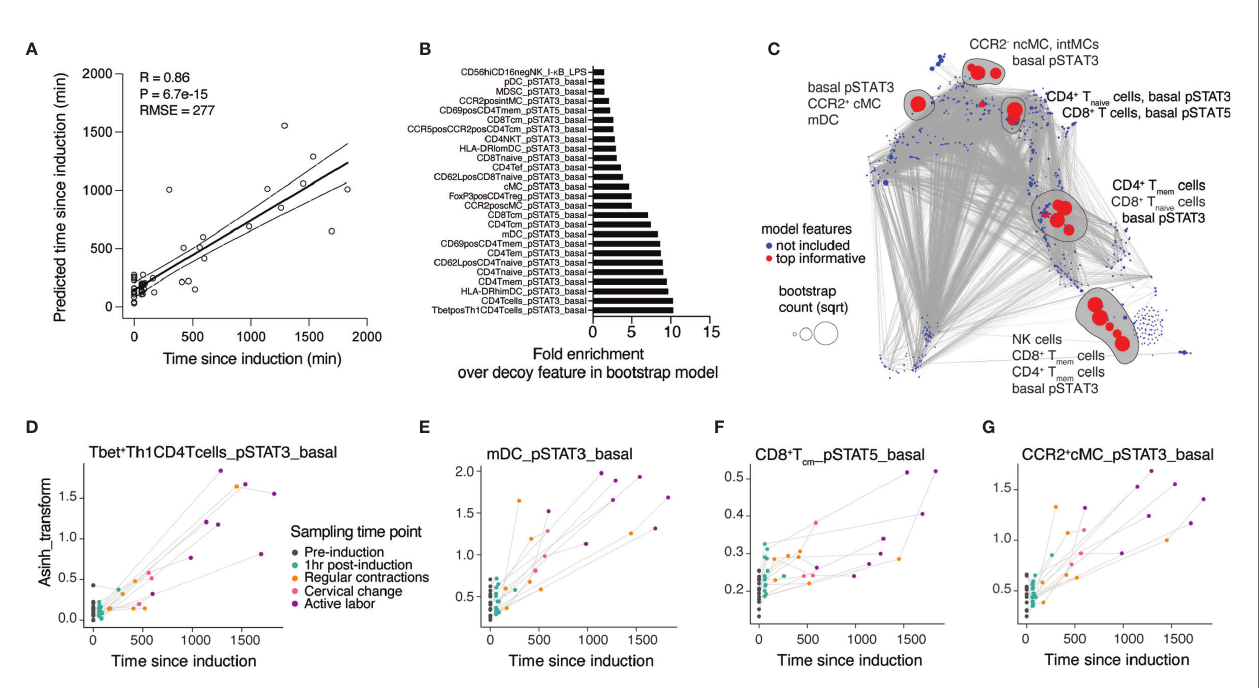
FIGURE 3 | A regression model accurately predicts dynamic changes of the maternal immune response throughout the latent phase of labor. (A) Regression of predicted vs. true time since induction (TSI) derived from the LASSO model (Spearman R = 0.86, cross-validation, p-value = 6.7e-15, RMSE = 277 min, N = 15 patients). (B) Top informative feature ranking derived from occurrences in a bootstrap analysis with 1,000 iterations. (C) Correlation network of cross-validated LASSO model predicting TSI at time of sampling. Red color highlights features top informative for the prediction model. Blue features did not inform the model and were not included. Dot size indicates the bootstrap count per feature (square-rooted). Top model features selected by bootstrap analyses are circled. (D – G) Dynamics of individual top model features across time points during latent labor. See also Supplementary Figure 2 and Supplementary Table 3